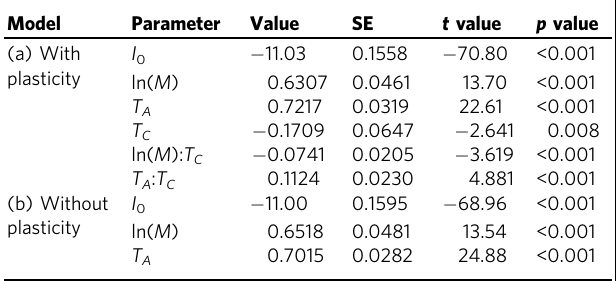
drivers of metabolic